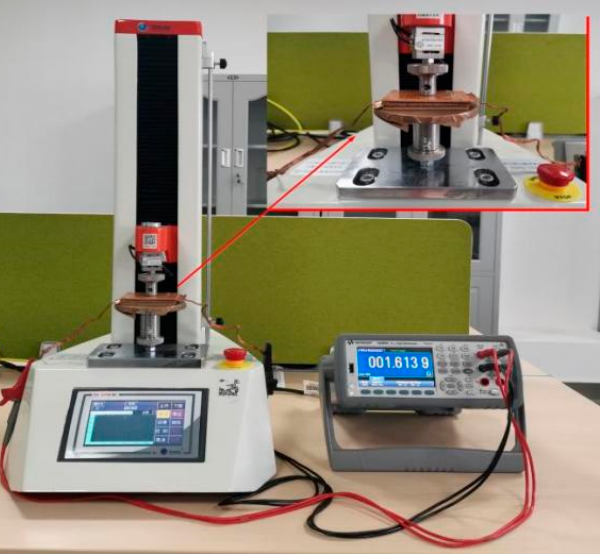
Figure 2. Sensor performance test system (( left ): press, ( right ): multimeter, ( inset ): resistance measuring point).